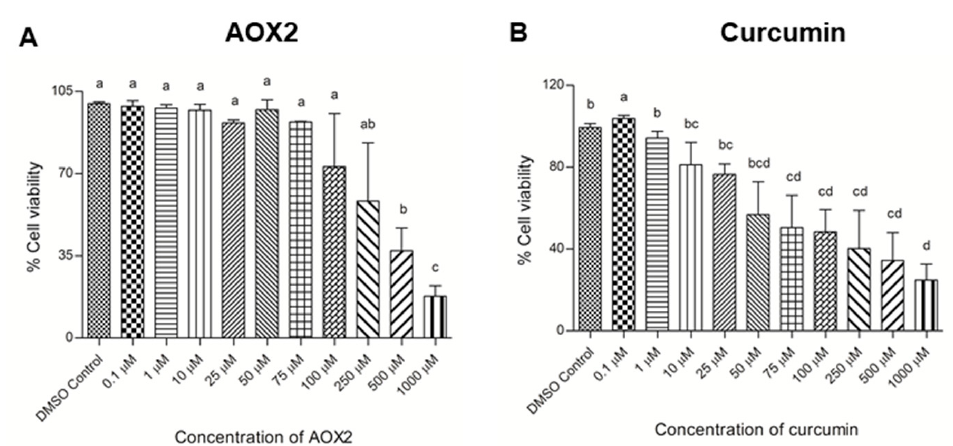
Figure 2. The viability of BEAS-2B cells against dose-dependent exposure to AOX2 ( A ) and curcumin ( B ) for 24 h. Experimental values are mean ± SD of three independent experiments in triplicate. One-way analysis of variance was performed with Tukey’s pairwise comparison. Means that share the same letter are not significantly different at p ≤ 0.05. Abbreviations: AOX2, dietary antioxidant formulation-2; DMSO, dimethyl sulfoxide.